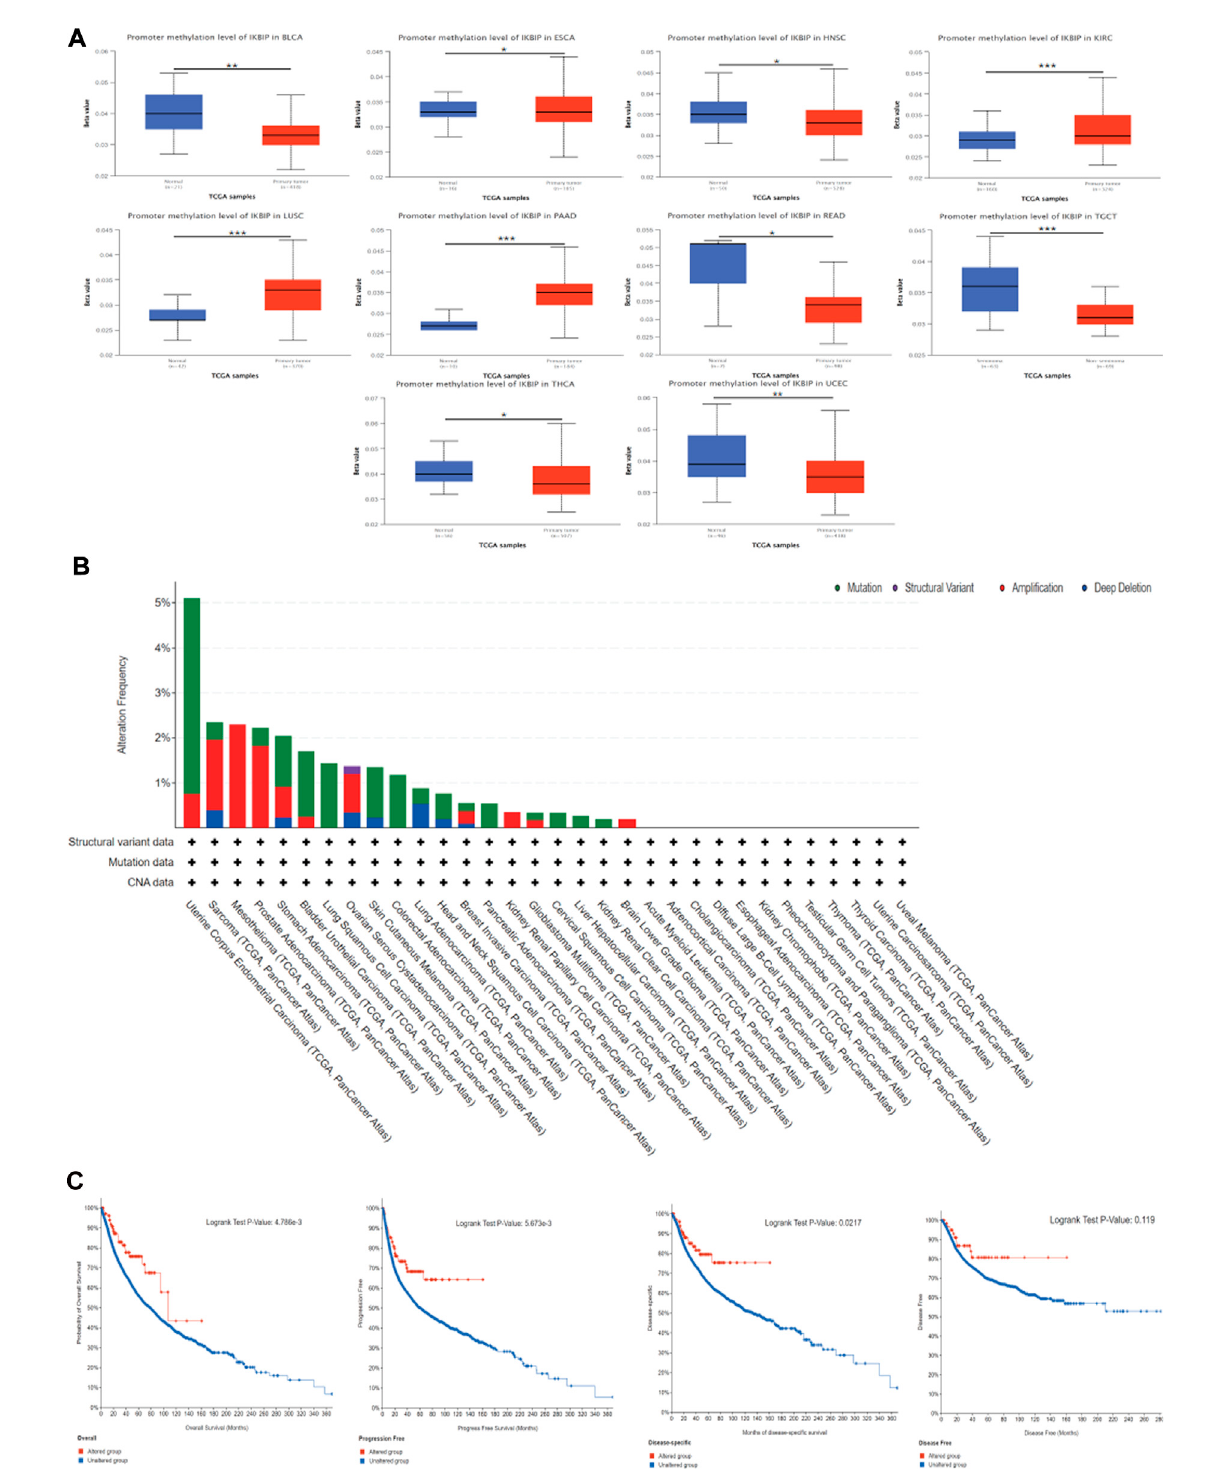
FIGURE 8 DNA methylation and mutation features of IKBIP in pan-cancer. (A) IKBIP promoter methylation in pan-cancer. (B) Using the cBioPortal database, the modi fi cation frequency with various mutation types was studied. (C) Utilizing the cBioPortal database, we analyzed how IKBIP mutation status affected overall, disease-speci fi c, disease-free, and progression-free survival in cancer patients. p p < 0.05, pp p < 0.01, and ppp p <